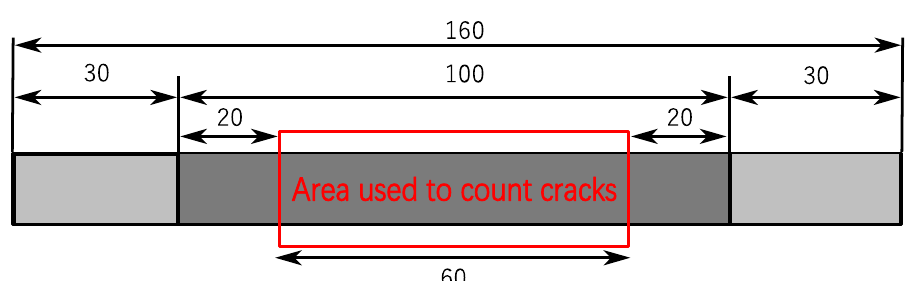
Figure 4. Area to count the number of transverse cracks (Unit: mm).